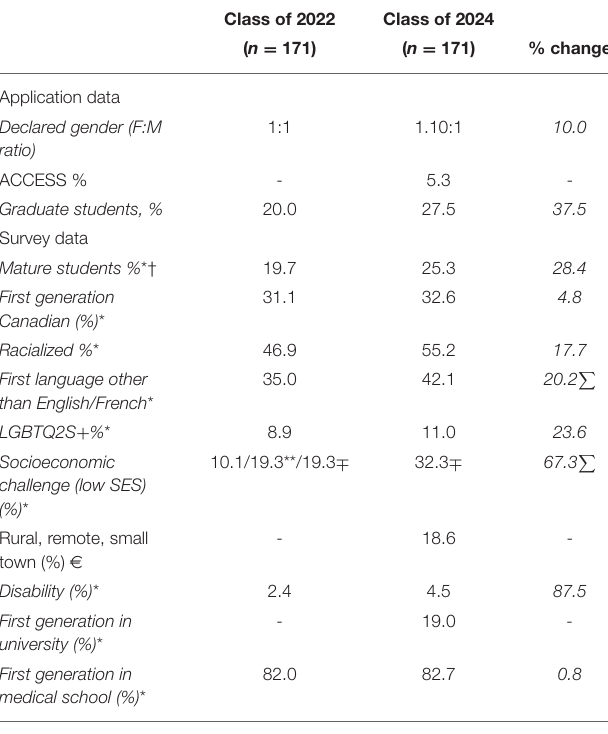
TABLE 2 | Diversity parameters for the Class of 2024 (post-initiatives) vs. Class of 2022